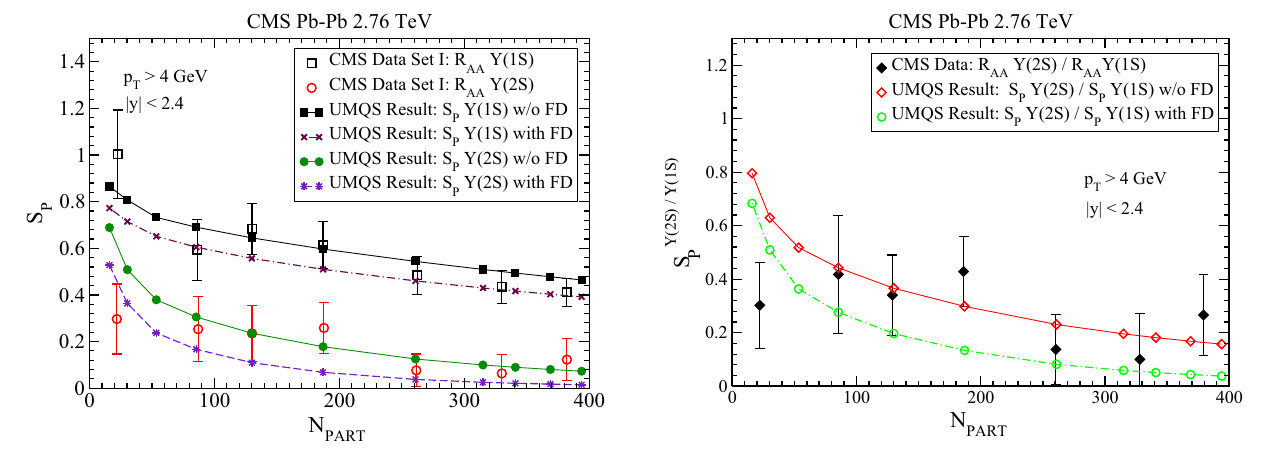
Fig. 12 The p T integrated survival probability of ϒ( nS ) is com- pared with R AA versus centrality in Pb-Pb collisions at TeV [52] at p T range: 5 < p T < 30 GeV